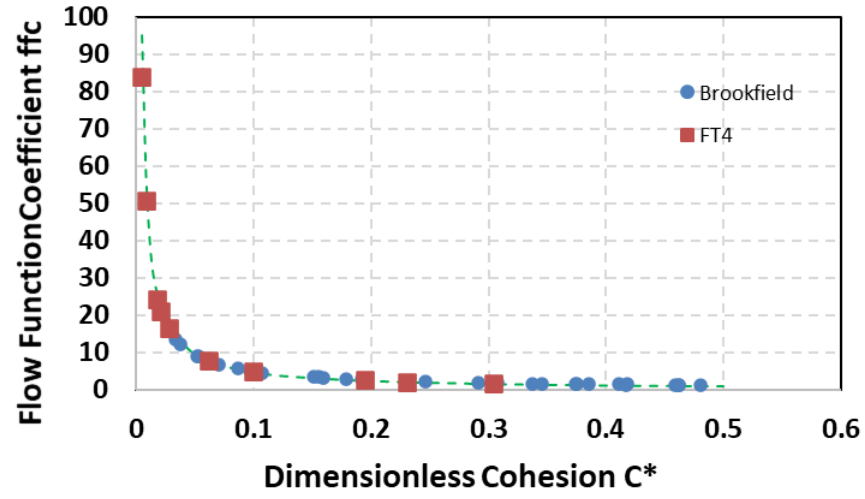
Figure 13. Normalising all flow function data using the method of Wang et al. [16]. Both the data from the Brookfield PFT and Freeman FT4 superimpose onto a single plot. Wang et al. [16] found that this plot could be represented by: